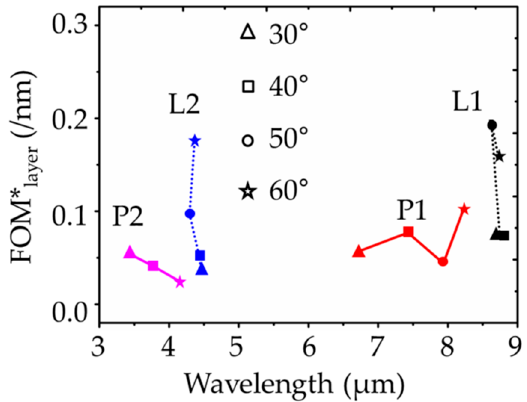
Figure 6. Experimental figure of merit FOM* layer of different modes in the metagrating sample.